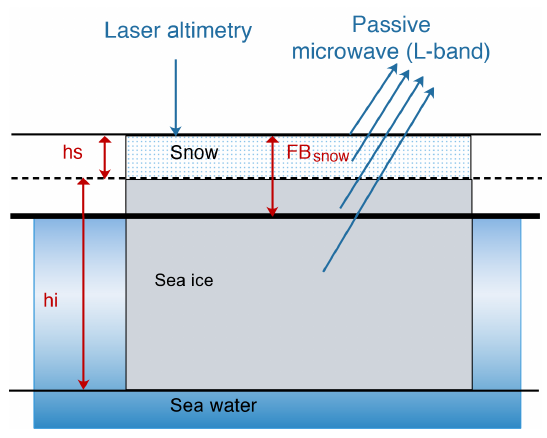
Figure 1. Sea ice parameters in the active and passive remote sens- ing of the sea ice cover, including sea ice thickness ( h i ), snow depth ( h s ) and snow freeboard (FB s